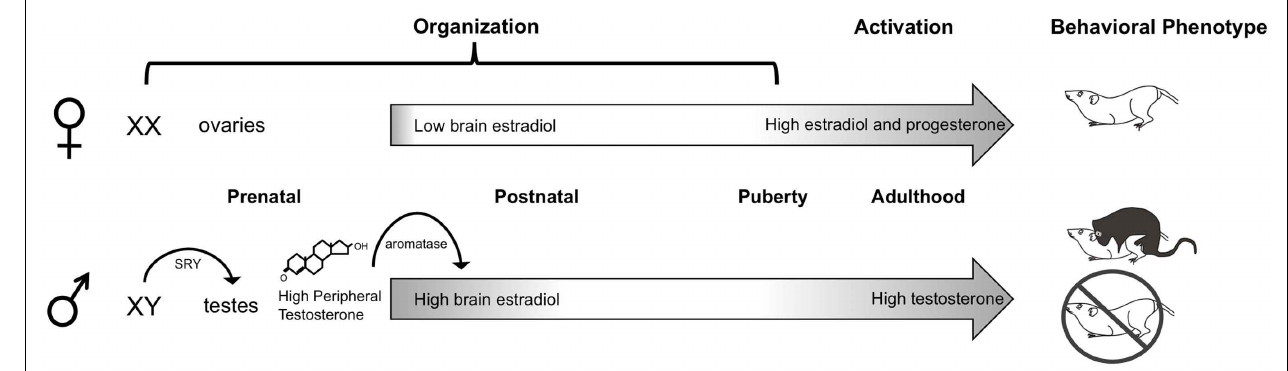
FIGURE 1 | Neonatal organization of the brain and behavior. In male rodents, the SRY gene on theY chromosome leads to the development of testes, which begin synthesizing androgens prenatally. Plasma testosterone levels rapidly increase late during the embryonic period and peak shortly after birth. Once in the brain, testosterone is converted by the p450 aromatase